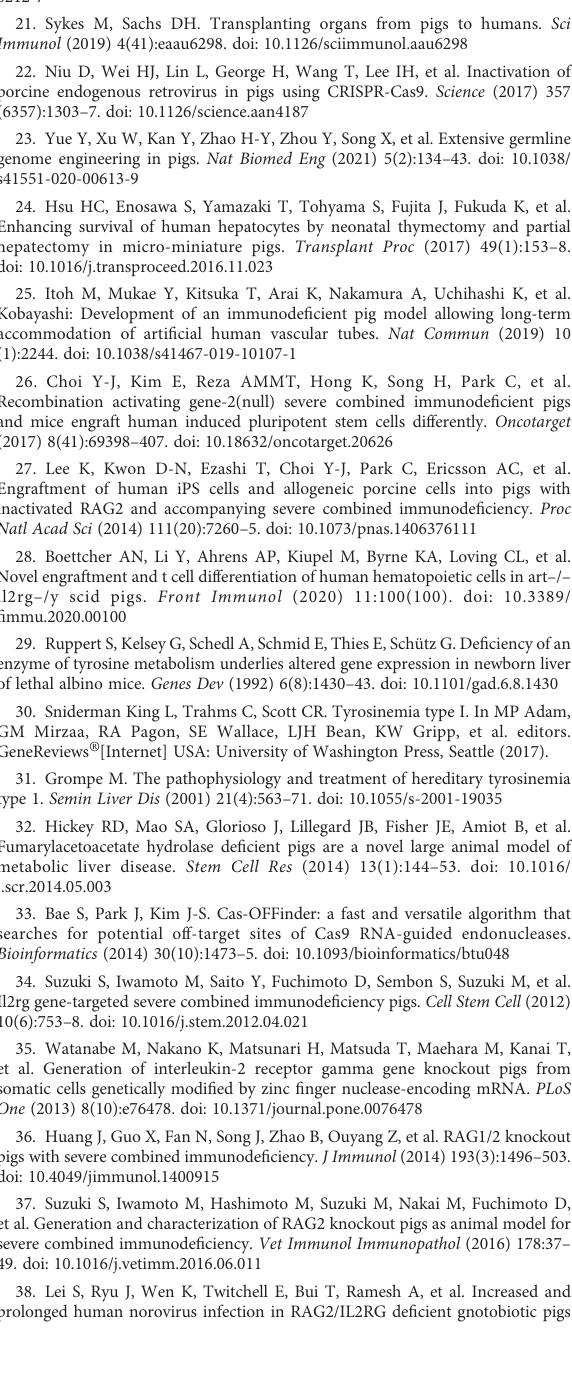
SUPPLEMENTARY TABLE 3 Primer sequences used to amplify RAG2, IL2R g and FAH. SUPPLEMENTARY TABLE 4 Primer sequences used for qPCR.